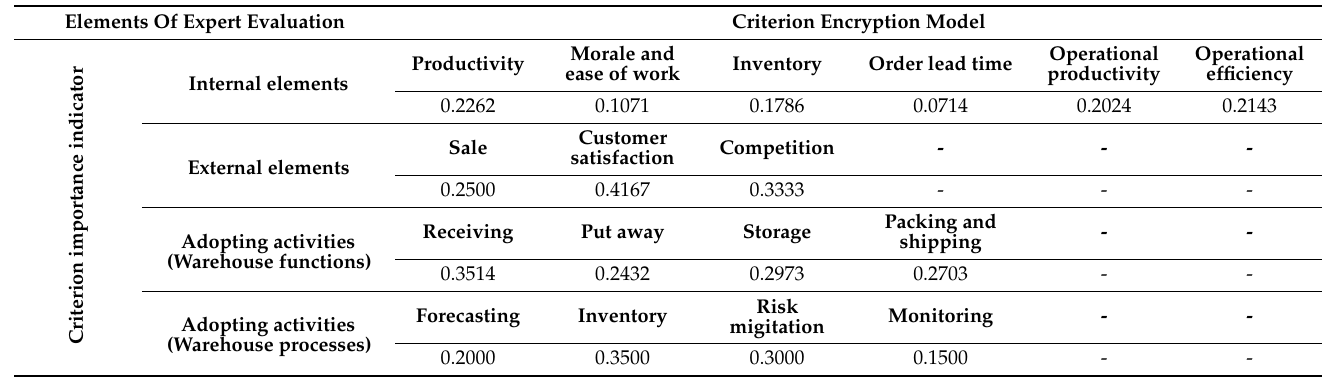
Table 15. Expert judgment of criterion importance indicator.